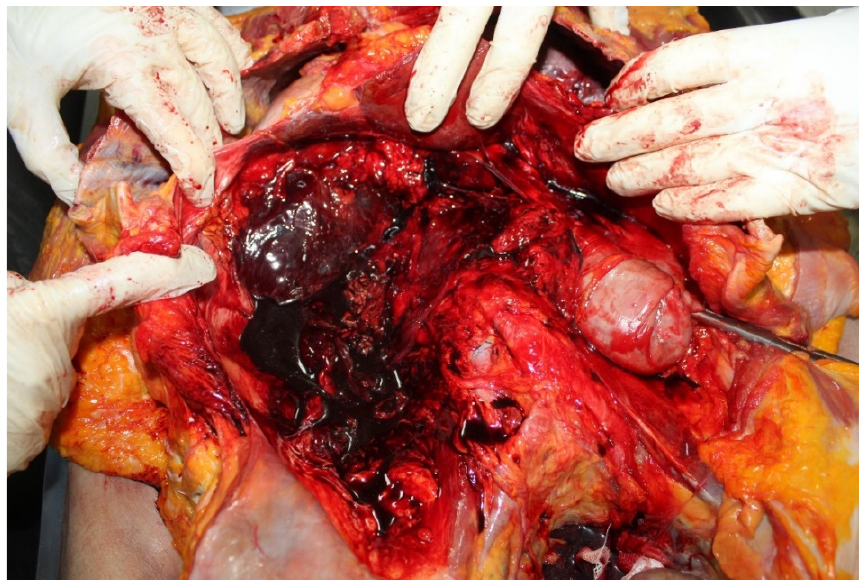
Figure 2. Abdominal trauma at autopsy in case 1.